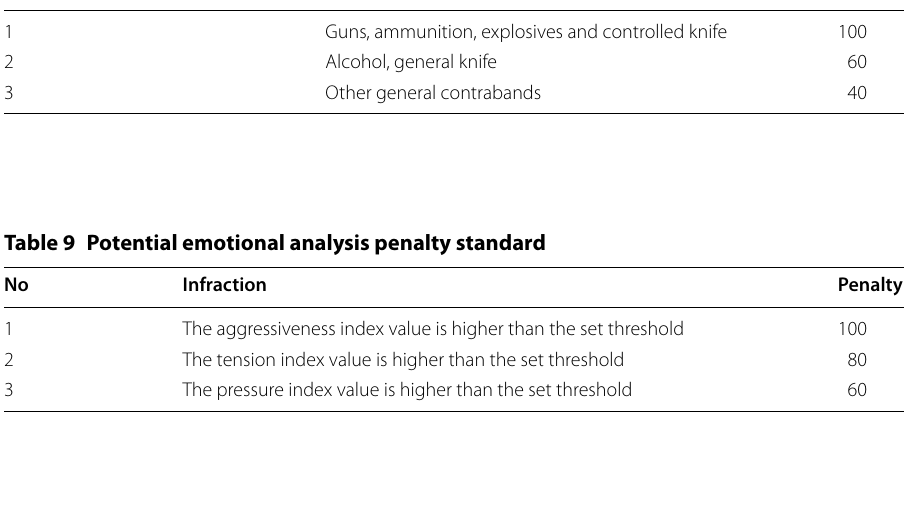
Table 8 Through-type millimeter-wave human body security detector penalty standard No